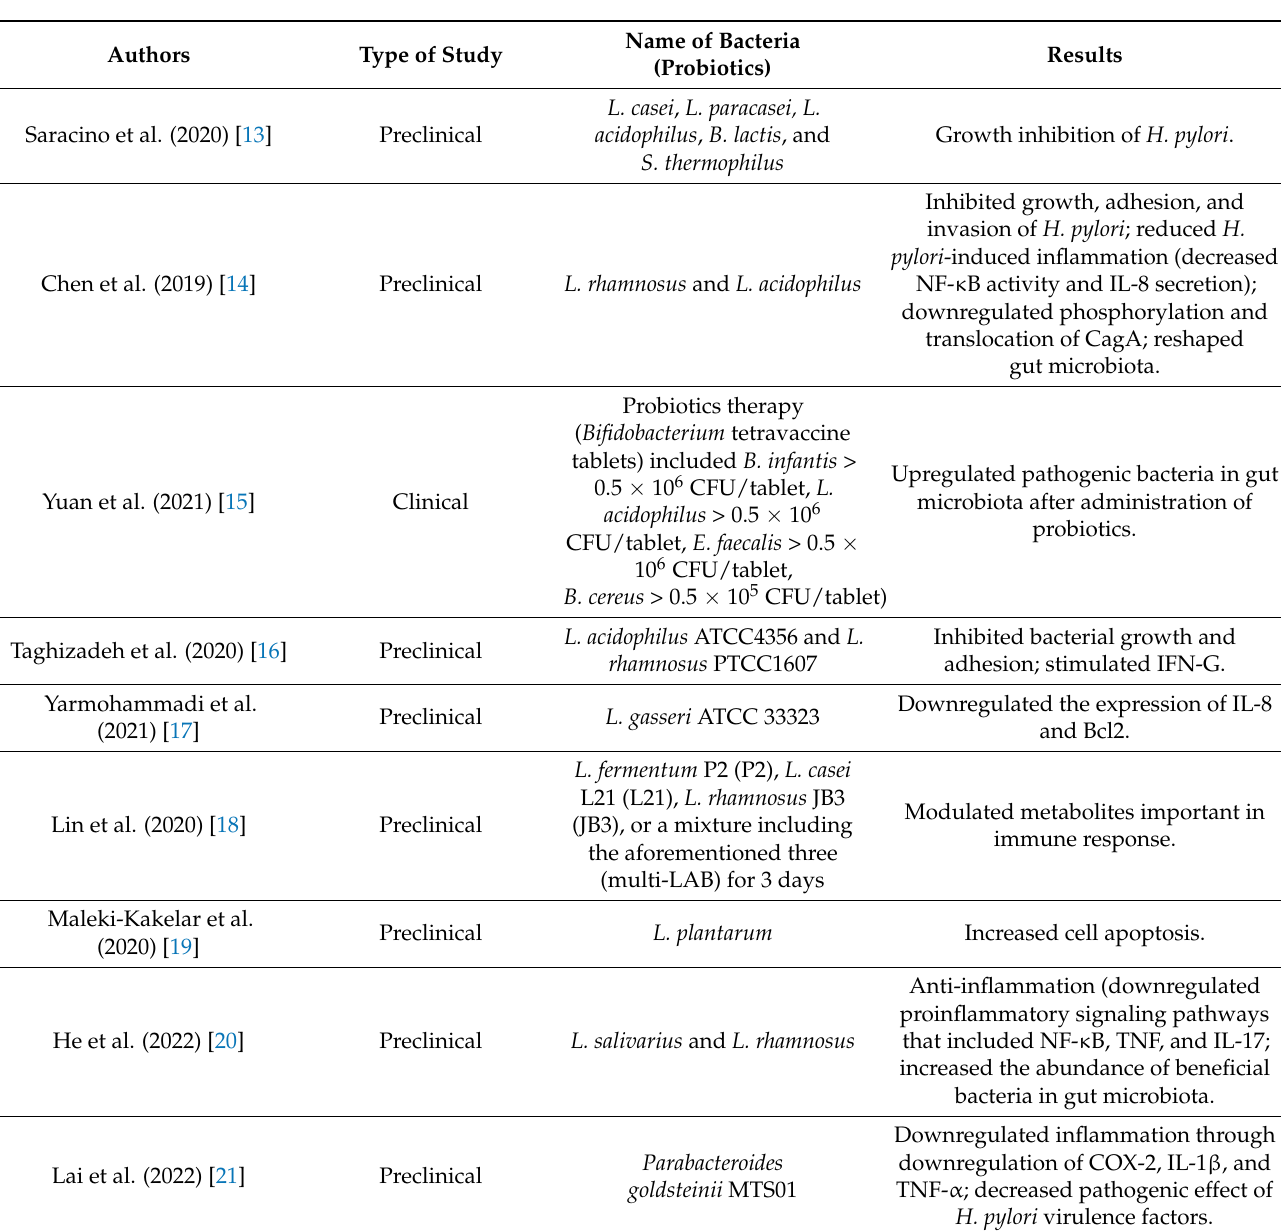
Table 1. List of potential probiotics and their antibacterial activity against H. pylori included in this systematic review. UBT: urea breath test; LAB: lactic acid